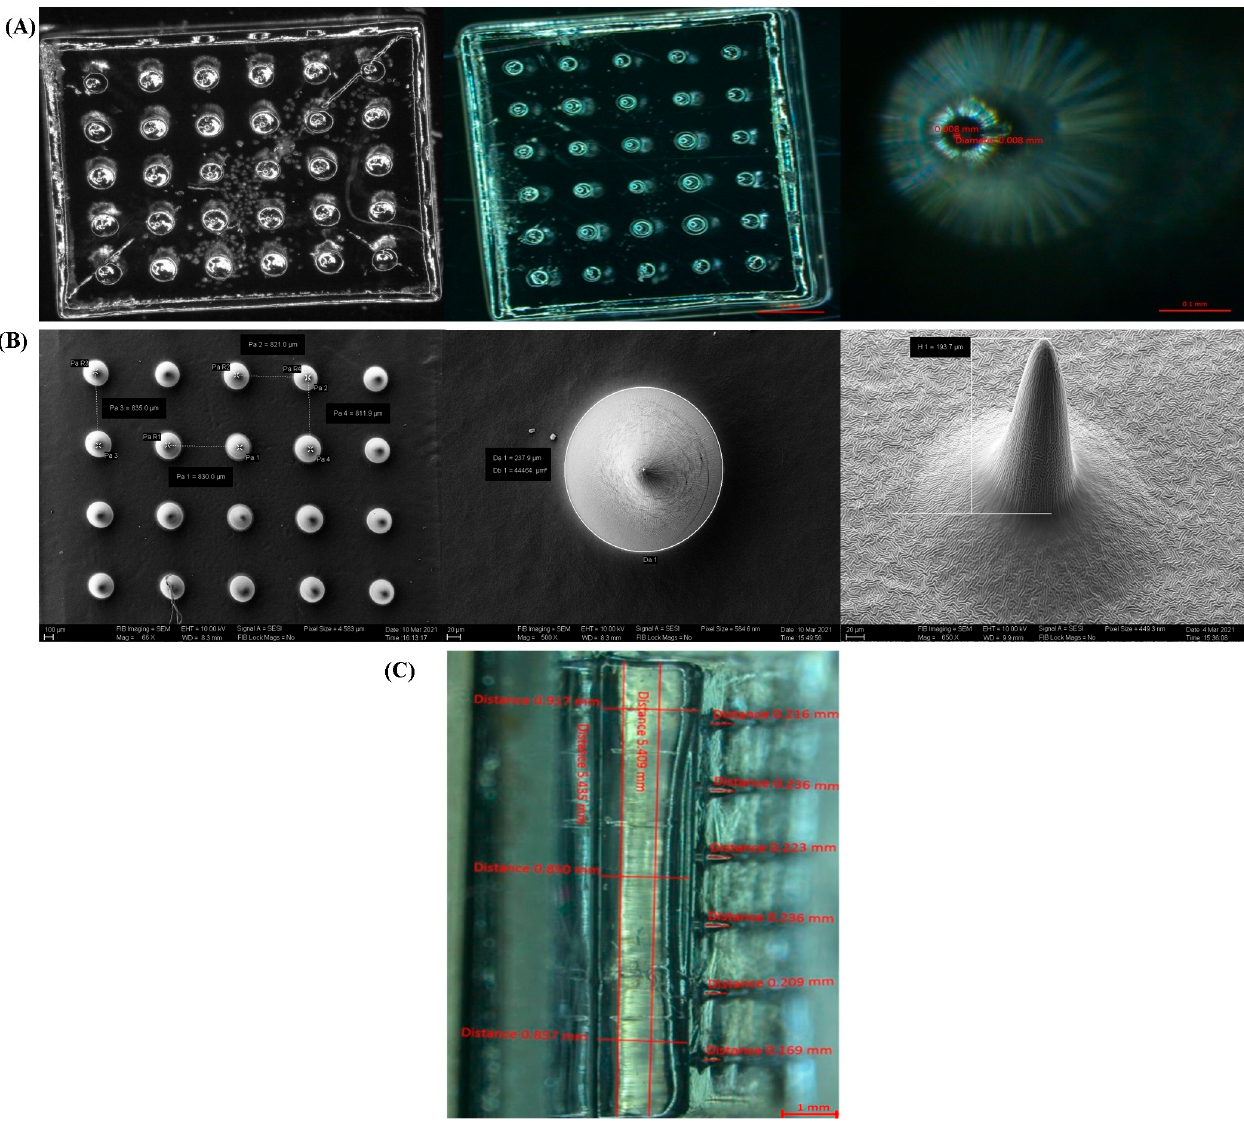
Figure 5. Dimensions of MNs ( A ) Stereomicroscopic images ( B ) Scanning electron microscopy images ( C ) Complete dimensions of a single fabricated microneedle patch in millimetres